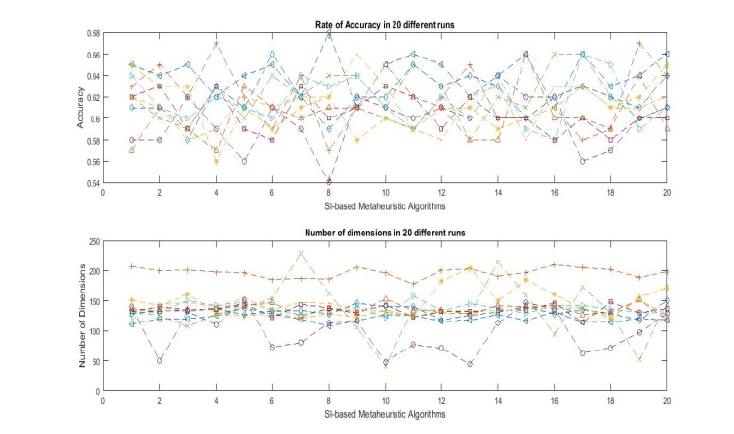
Figure 6. Variation of the rate of accuracy and number of dimensions of SI-based